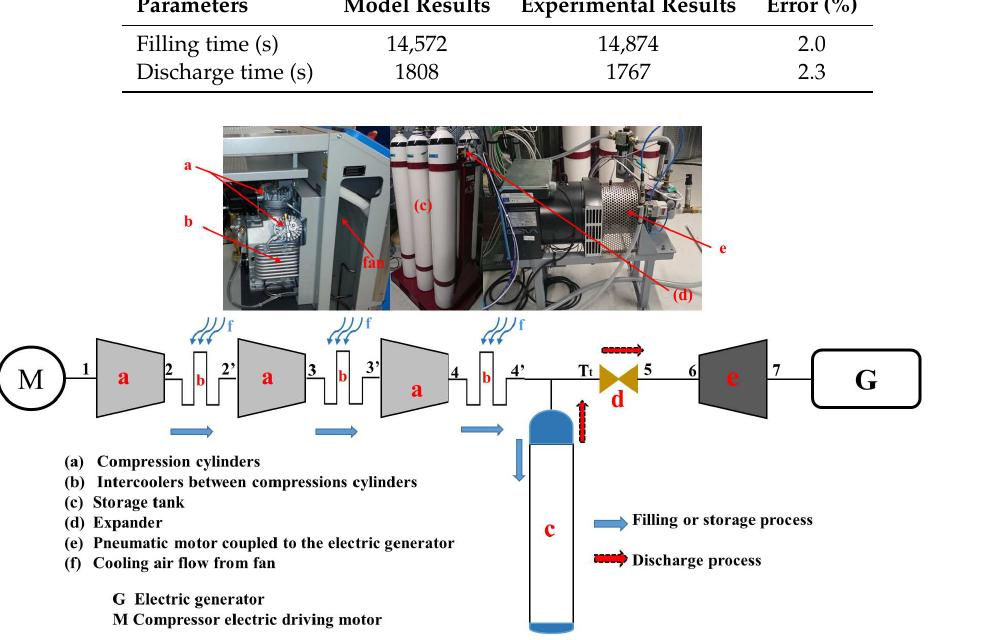
Figure 4. Global view and diagram of pilot